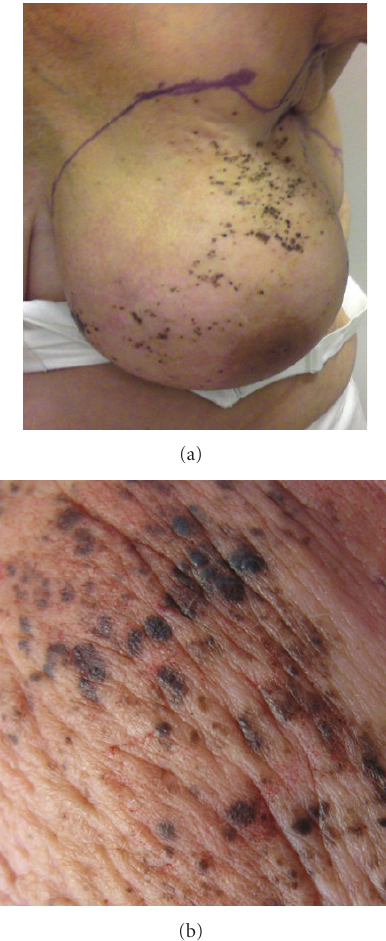
Figure 1: (a) Large numbers of pigmented areas on the skin of the a ff ected breast. (b) Pigmented maculae.